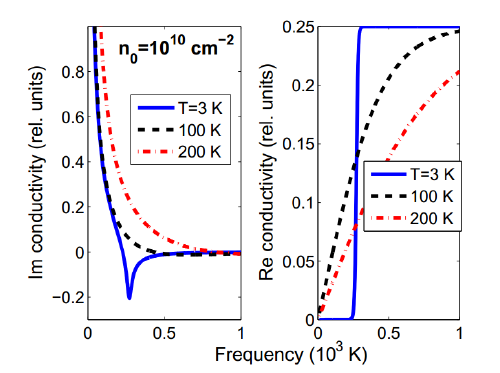
Figure 1. Conductivity calculation using different temperatures. The left part is imaginary and the right one is the real part. In addition, the density of carrier n 0 = 10 10 cm − 2 is considered. The experimental results are obtained using different temperatures, which is shown in these figures. Reprinted with permission from [25]. Copyright (2008) Journal of Physics: Conference Series, IOP Publishing.